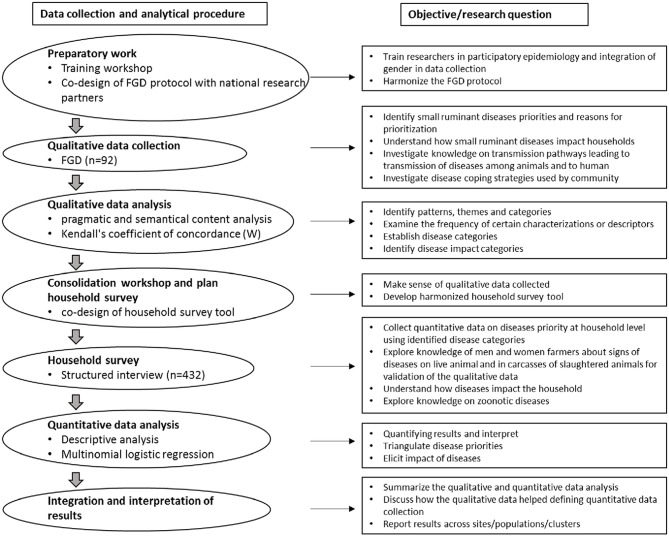
The conceptual overview of mixed methods and analytical approach.